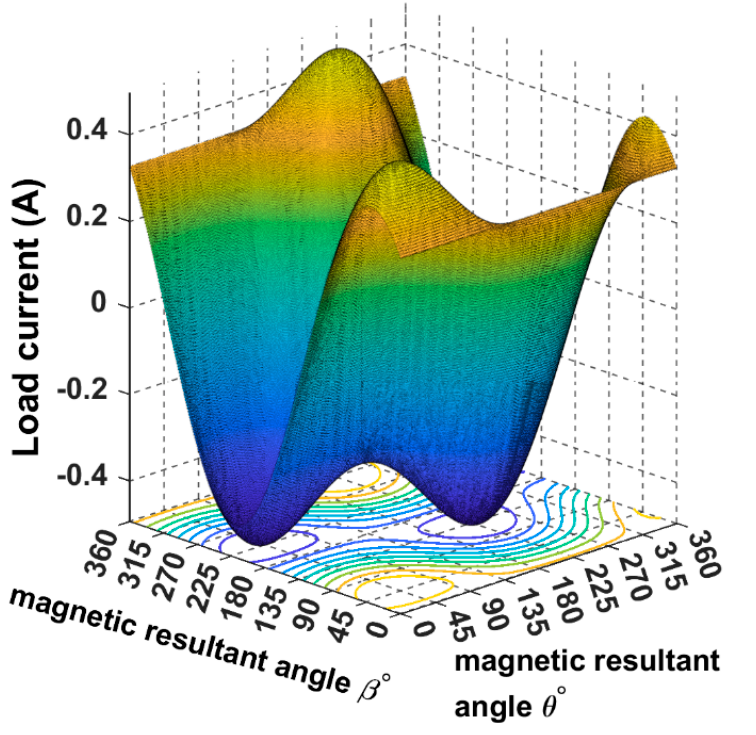
Figure 4. The load current when the magnetic field rotates around the origin and the receiver is placed at α = φ =45°.